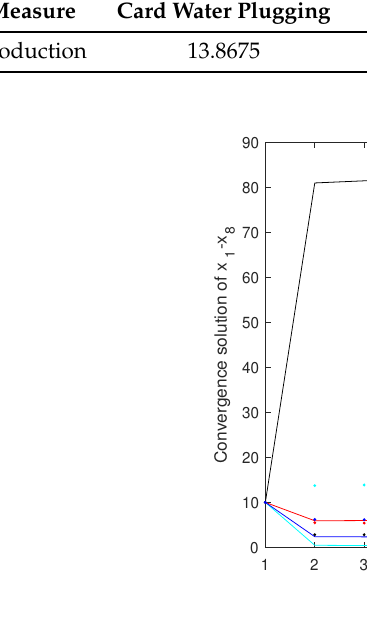
Figure 1. Convergence result of Algorithm